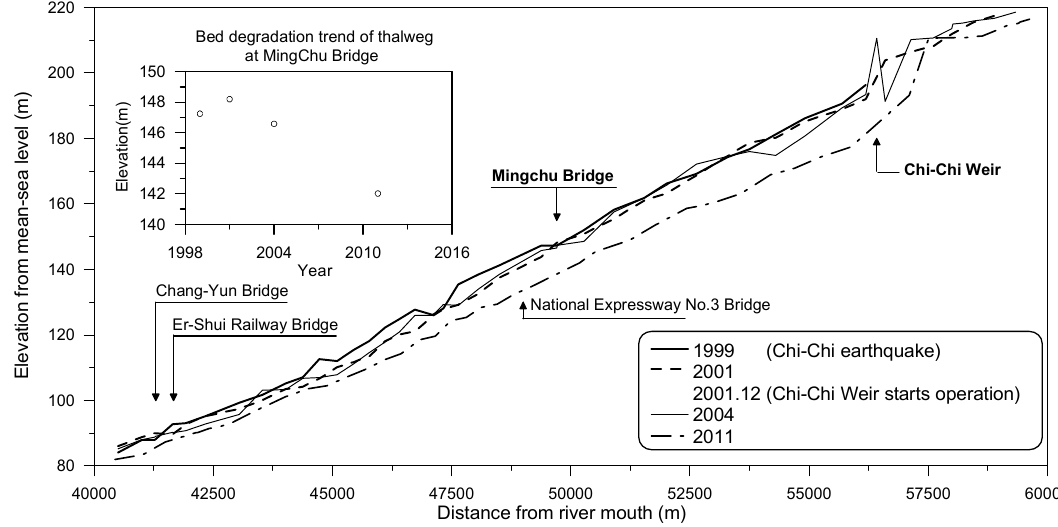
Figure 2. Variations of longitudinal riverbed profiles of Cho-Shui River near Mingchu Bridge.